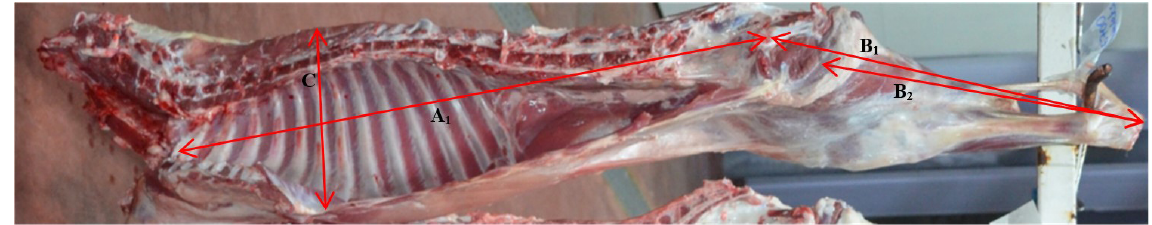
Figure 1. Carcass measurements ( A 1 : internal carcass length, B 1 − 2 : leg lengths, C : chest depth).